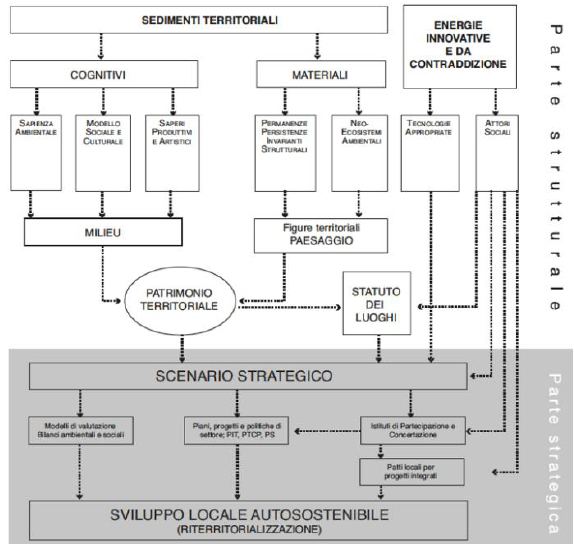
Figure 2. Alberto Magnaghi. Analytical methodology towards an integrated plan for territory (Poli, 2011a, p.